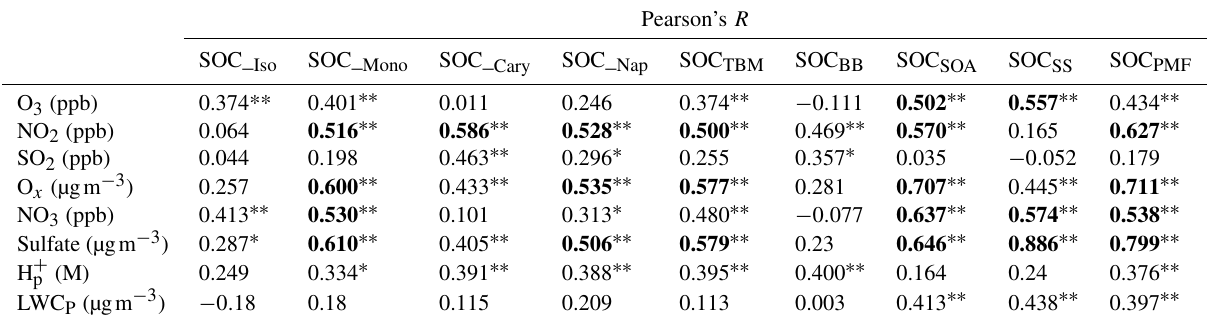
Table 3. Regression analysis (Pearson’s R ) of PMF and TBM-resolved SOCs, SO 2 , NO 2 , O 3 , tropospheric odd oxygen (O x ), particle acidity (H + p ), total particle-phase liquate water content (LWC P ), and sulfate **: P < 0 . 01; *: P < 0 . 05. Note that values of R > 0 . 5 are